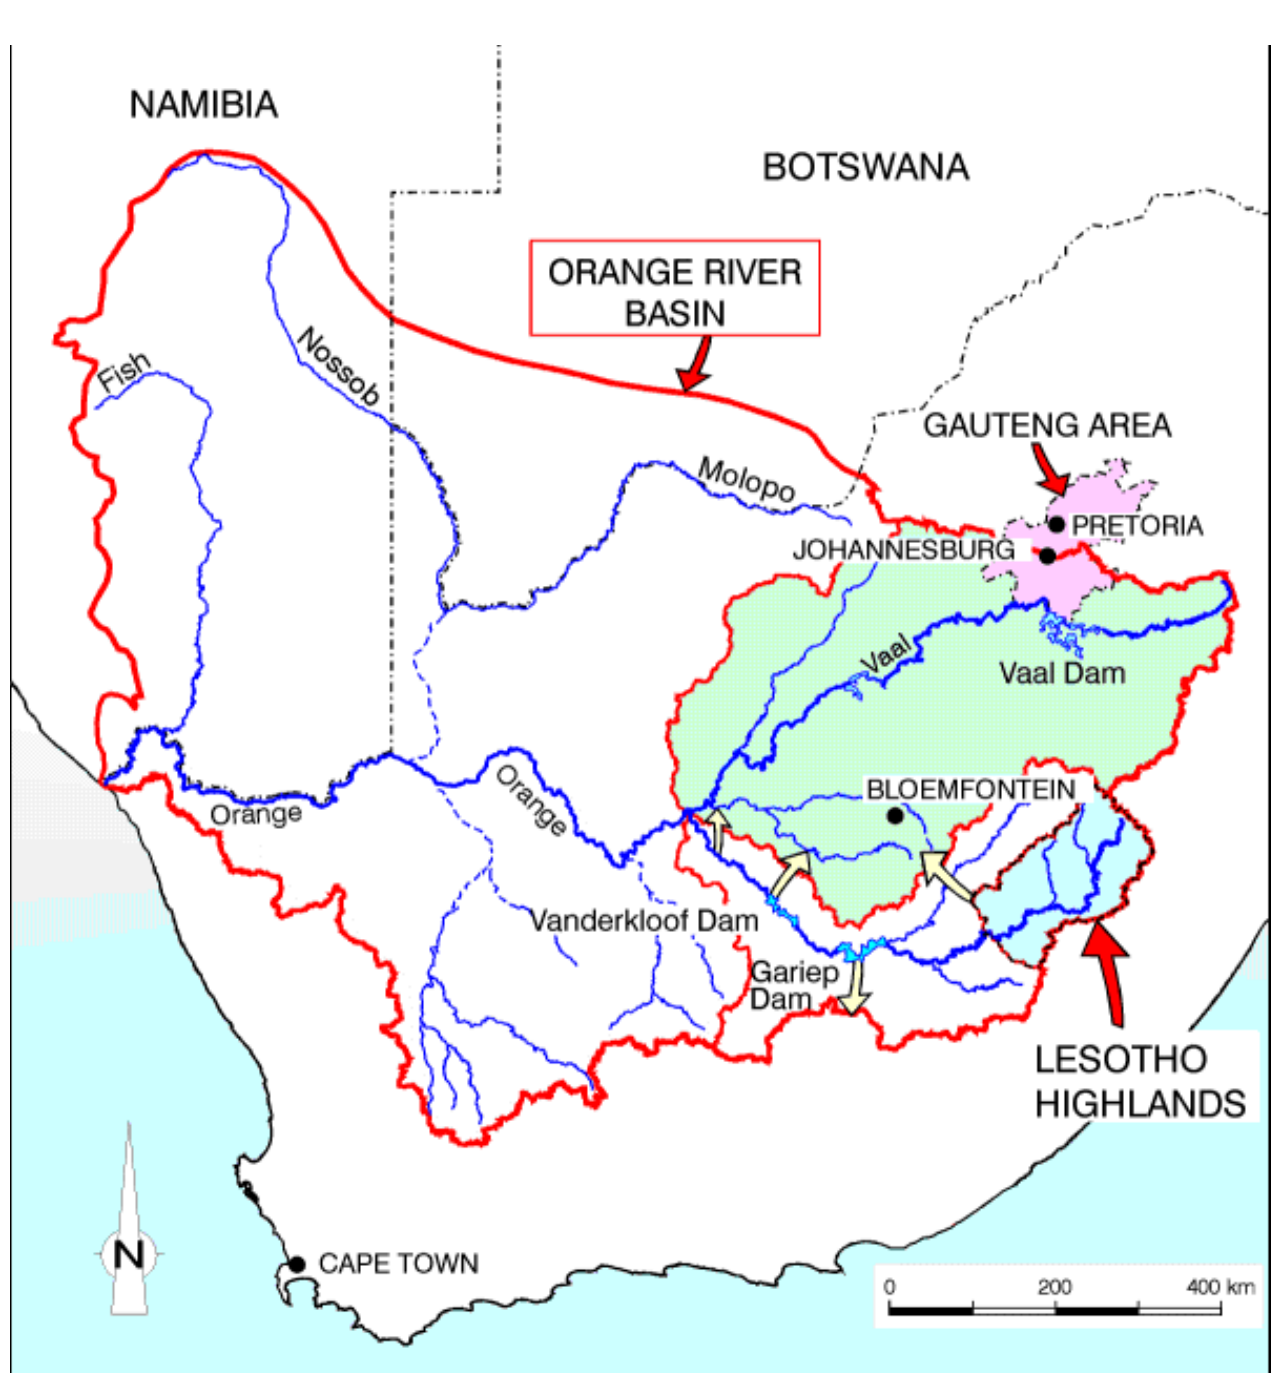
Fig. 4. Map of the Orange basin (South African Department of Water Affairs and Forestry, retrieved 22 August 2007 from